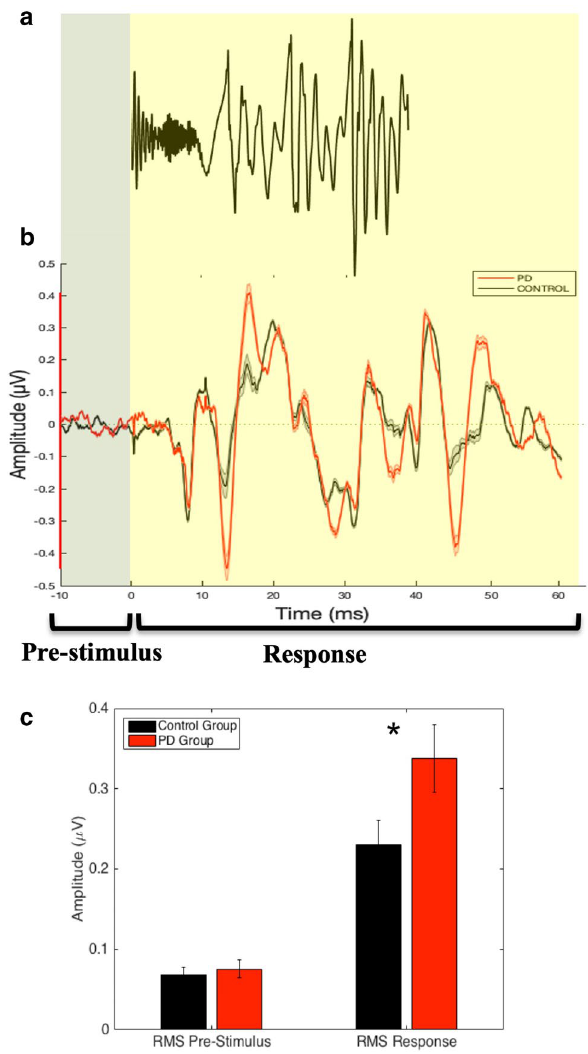
Figure 1. ( a ) Stimulus waveform. ( b ) Average waveform brainstem response to [da] in individuals with PD (red) and age- and gender-matched controls (black). The pre-stimulus period (− 10 to 0 ms) and the response period (0 to 60 ms) are shown. ( c ) Bar graph demonstrating between-group differences in RMS amplitude for the pre-stimulus and response periods. The error and shaded error bars represent the standard error. Note : * p <